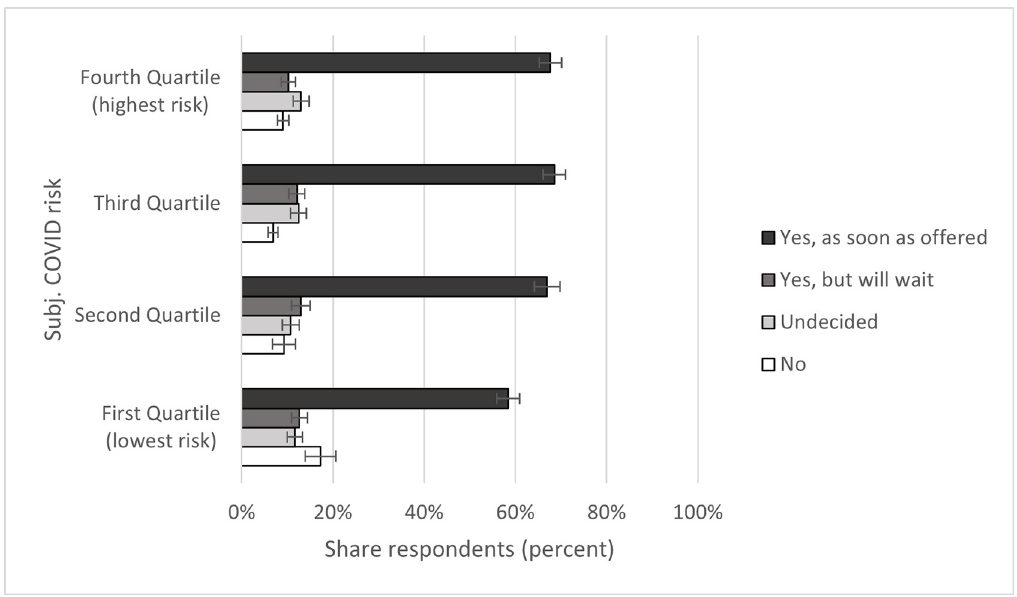
Fig 2. Subjective COVID risk and vaccine acceptance. Data: SOEP-CoV survey. Own calculations, weighted. 95% confidence intervals.